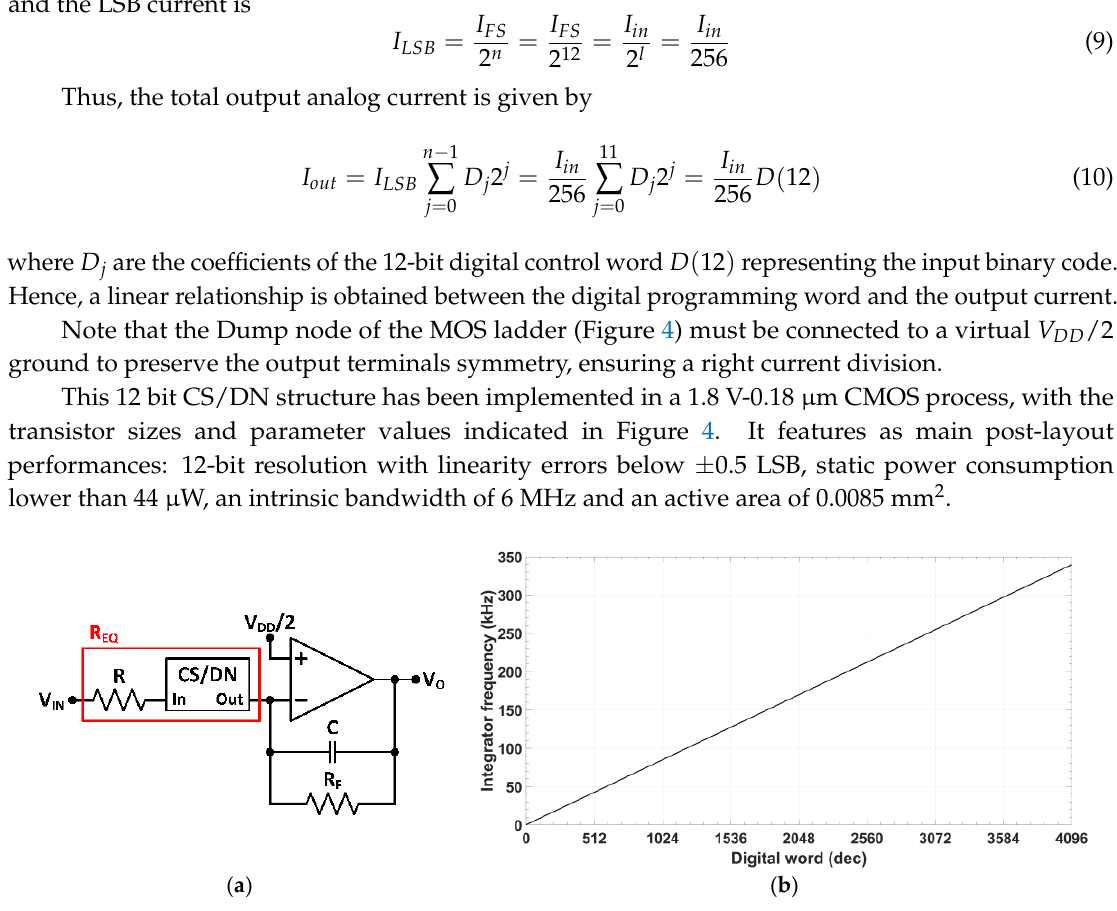
Figure 5. ( a ) Active-RC integrator built around the proposed OpAmp and CS/DN; and ( b ) simulated integrator characteristic frequency.